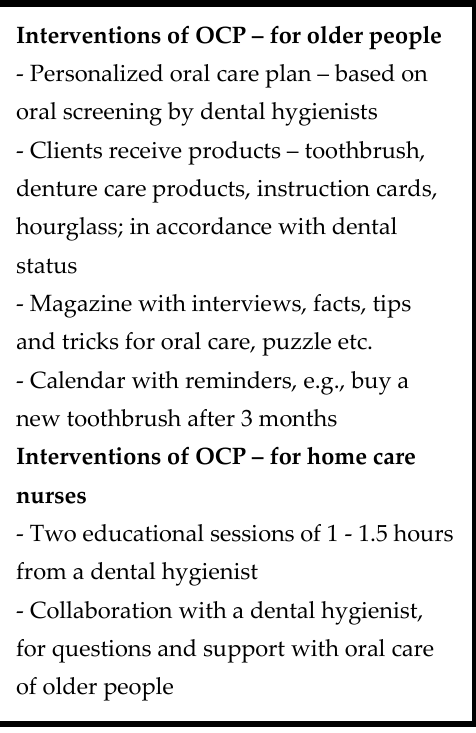
Figure 1. Interventions of OCP for older people and home care nurses.